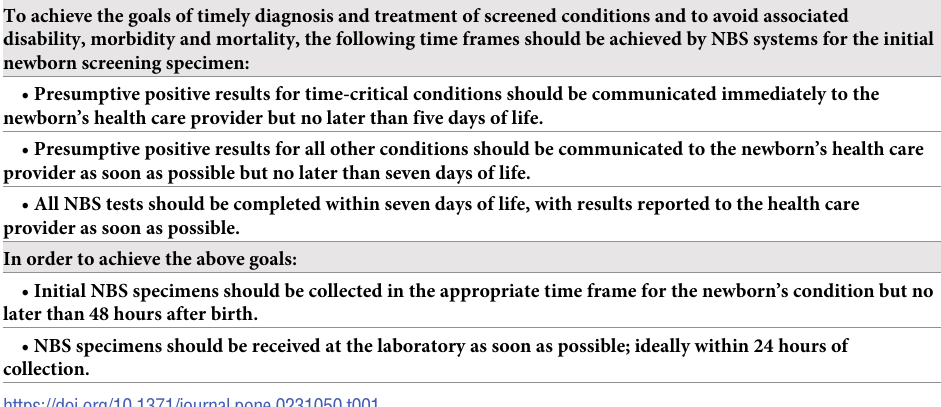
Table 1. Newborn screening timeliness goals from the Advisory Committee on Heritable Disorders in Newborns and Children (ACHDNC) [7]. To achieve the goals of timely diagnosis and treatment of screened conditions and to avoid associated disability, morbidity and mortality, the following time frames should be achieved by NBS systems for the initial newborn screening